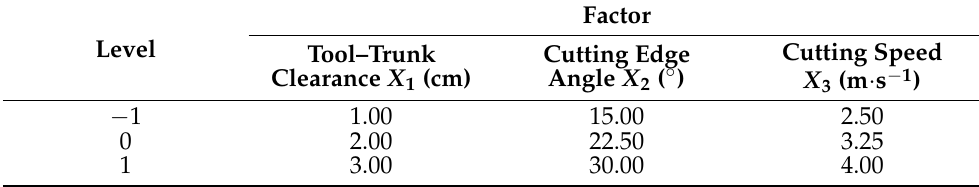
Table 2. Factors and factor levels of the